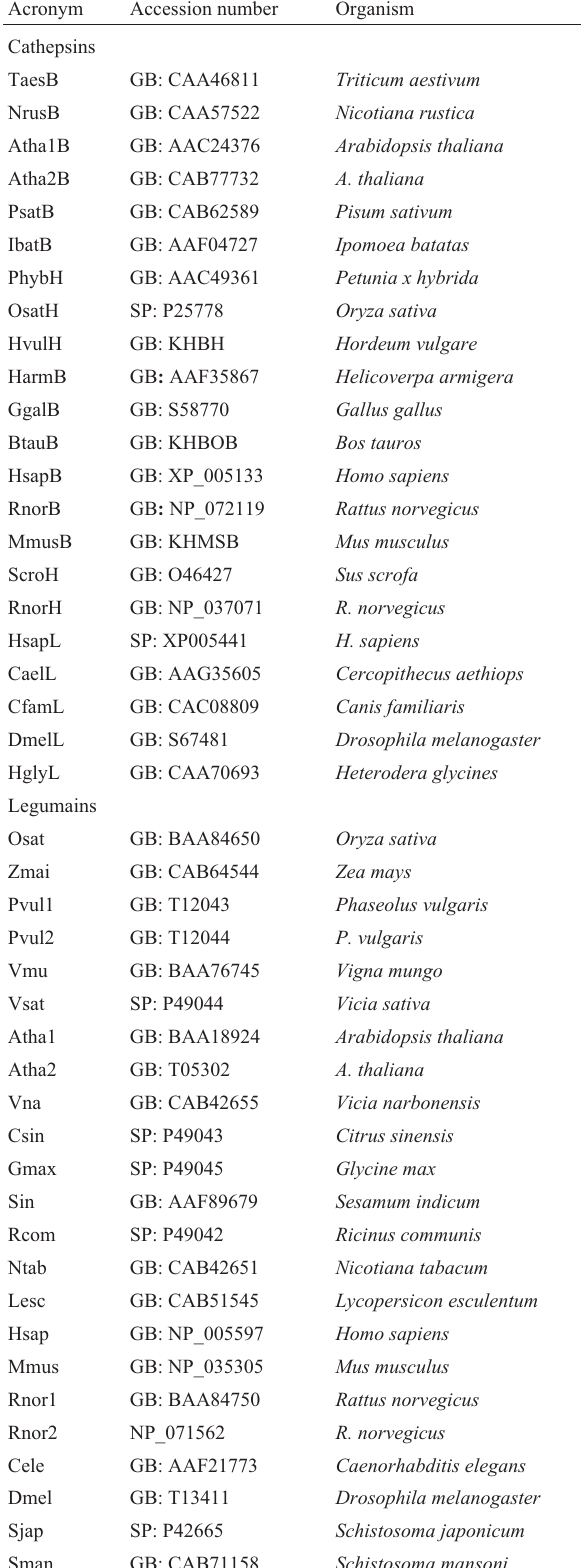
Table II - Cysteine proteinases from plants, vertebrates and